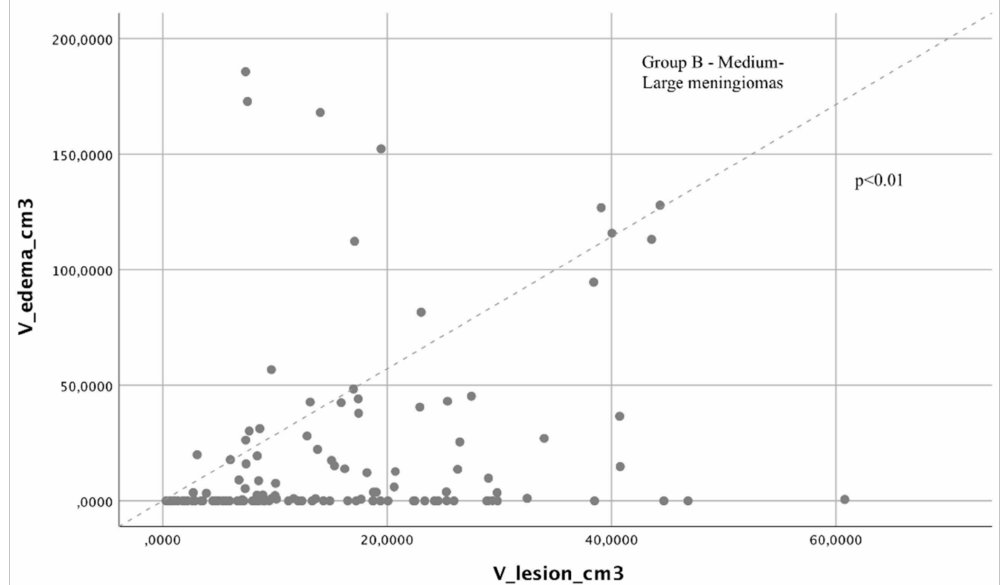
Figure 4. Through an ANOVA study, we found statistically significant differences between the reduction in performance in the postoperative phase and at the last evaluation among the various locations of GIMs.